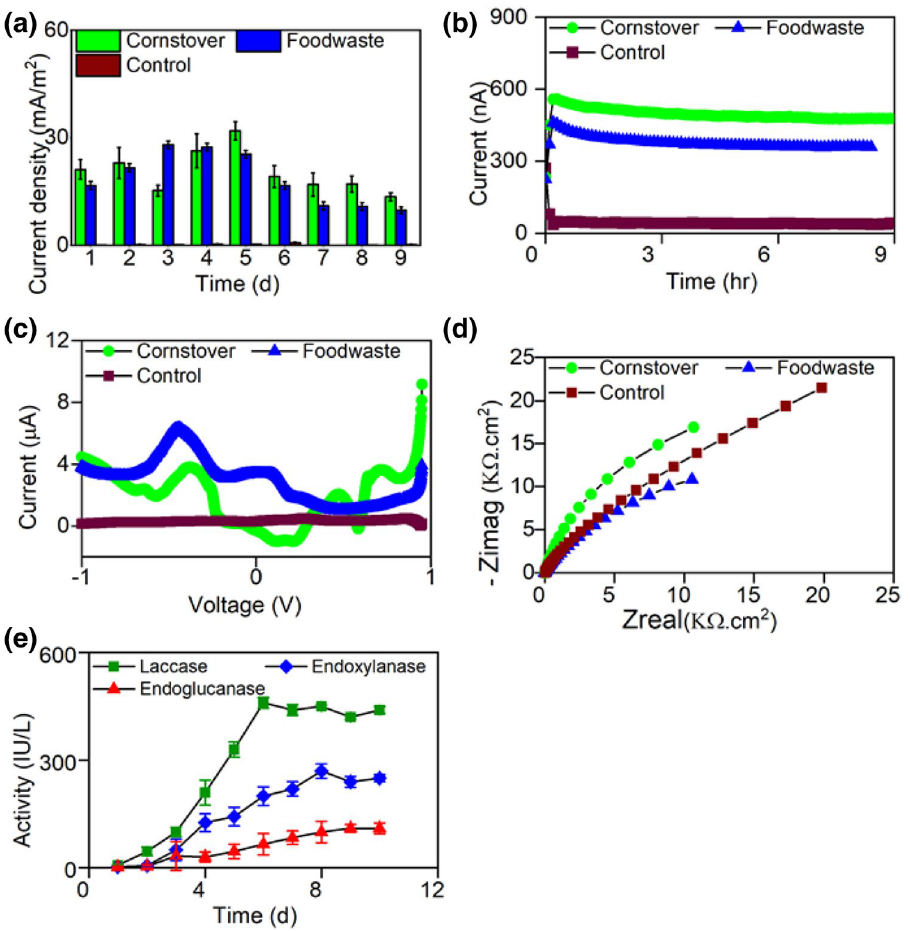
Figure 3. Substrate versatility analysis of strain WSUCF1 using corn stover, food waste and control ( a ) Temporal current density; ( b ) Temporal current variation; ( c ) Representative differential pulse voltammetry scan; ( d ) Nyquist plots for the entire frequency range (10 kHz to 10 MHz); ( e ) Lignolytic enzyme activities in Geobacillus sp. WSUCF1 in presence of 1% corn stover. Notes: All experiments were carried out in a 3-electrode electrochemical cell. Experimental details of the cyclic fed-batch processes are shown in Table